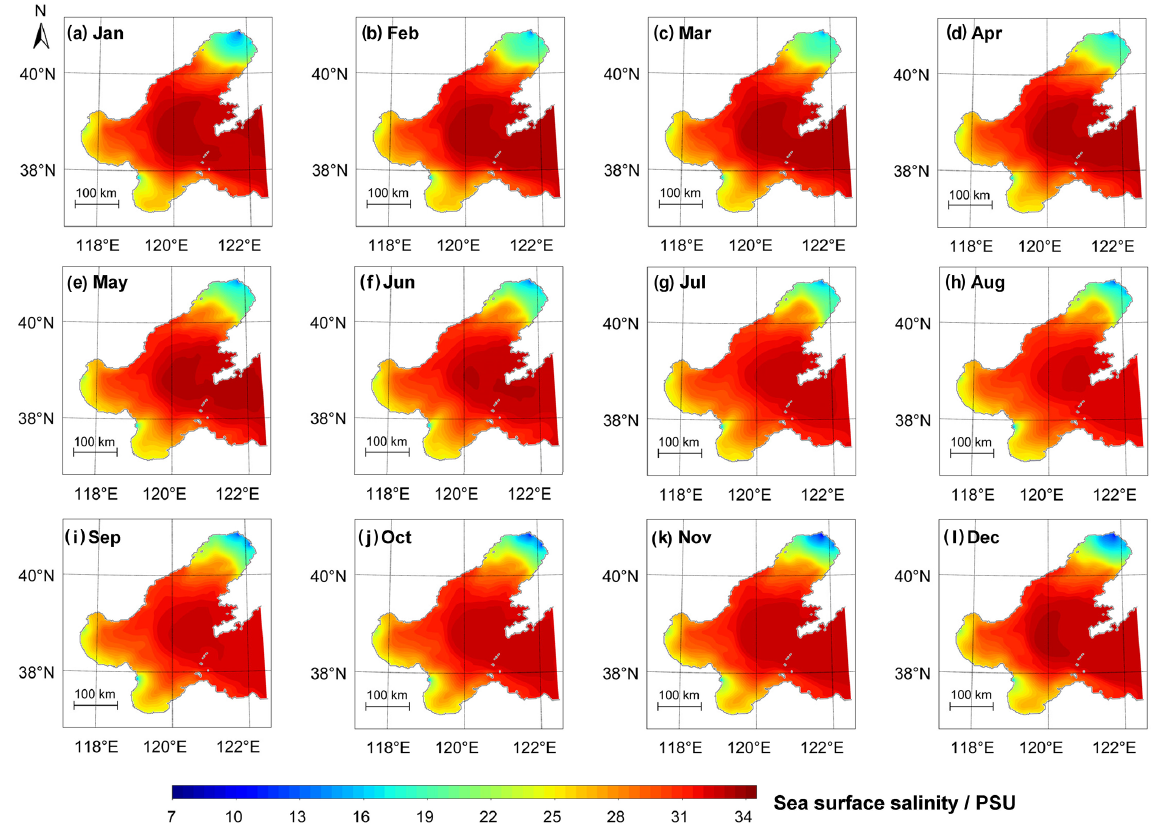
Figure 13. Spatial distributions of multi-year monthly average sea surface salinity (PSU) in the Bohai Sea during 1996–2017.